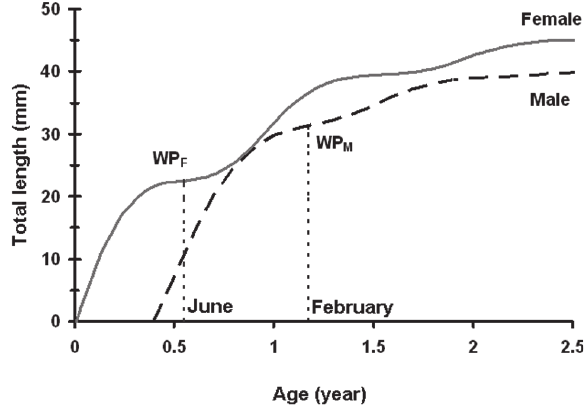
Fig . 4. – Winter points in the seasonal von Bertalanffy growth curves for females (WP ) and males (WP ) of Palaemon elegans . F m